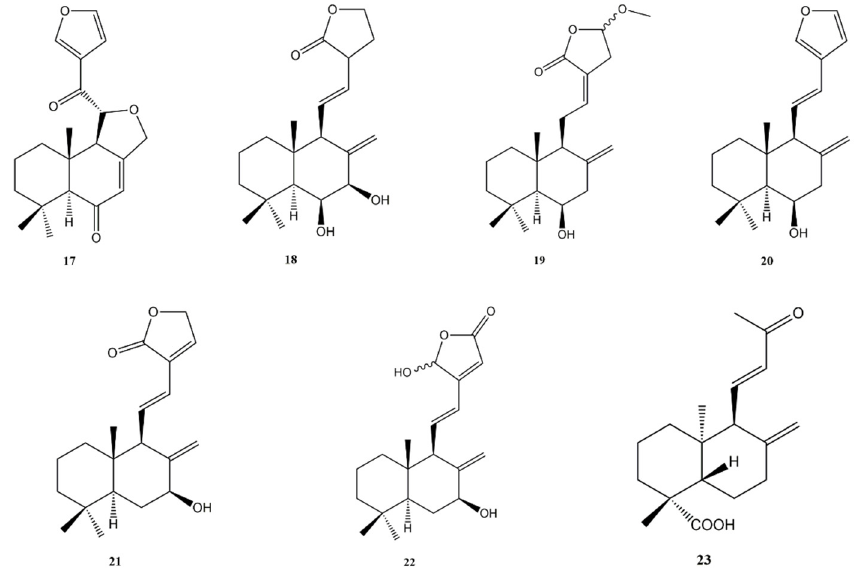
Figure 4. Bioactive labdane diterpenes: Hedylongnoid A ( 17 ); Hedylongnoid B ( 18 ); Hedylongnoid C ( 19 ); Yunnancoronarin A ( 20 ); Hedyforrestin B ( 21 ); Hedyforrestin C ( 22 ); (1R,4aS,5R,8aS)-1,4a- dimethyl-5-[(1E)-3-oxobut-1-en-1-yl]decahydronaphthalene-1-carboxylic acid ( 23 ).